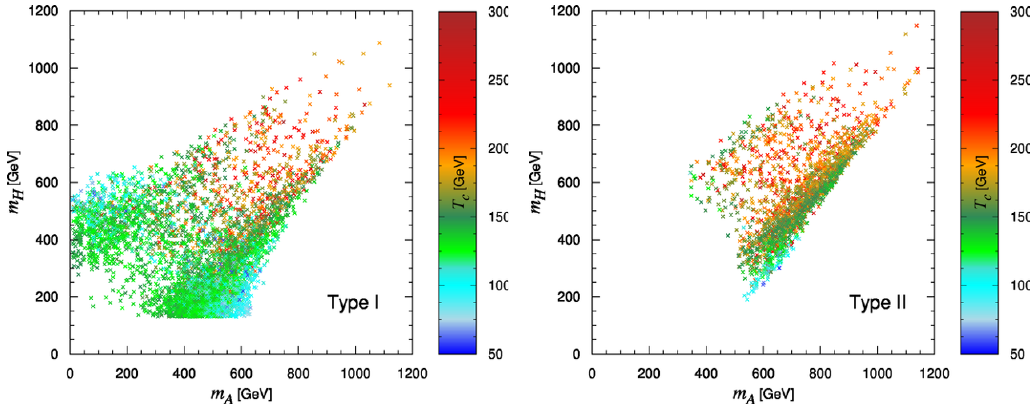
Figure 10 . We present the critical temperature in the mass spectrum of the model. Only T c . 300 GeV points obeying the strong (cid:12)rst order EWPT condition (cid:24) (cid:21) 0 : 7 are